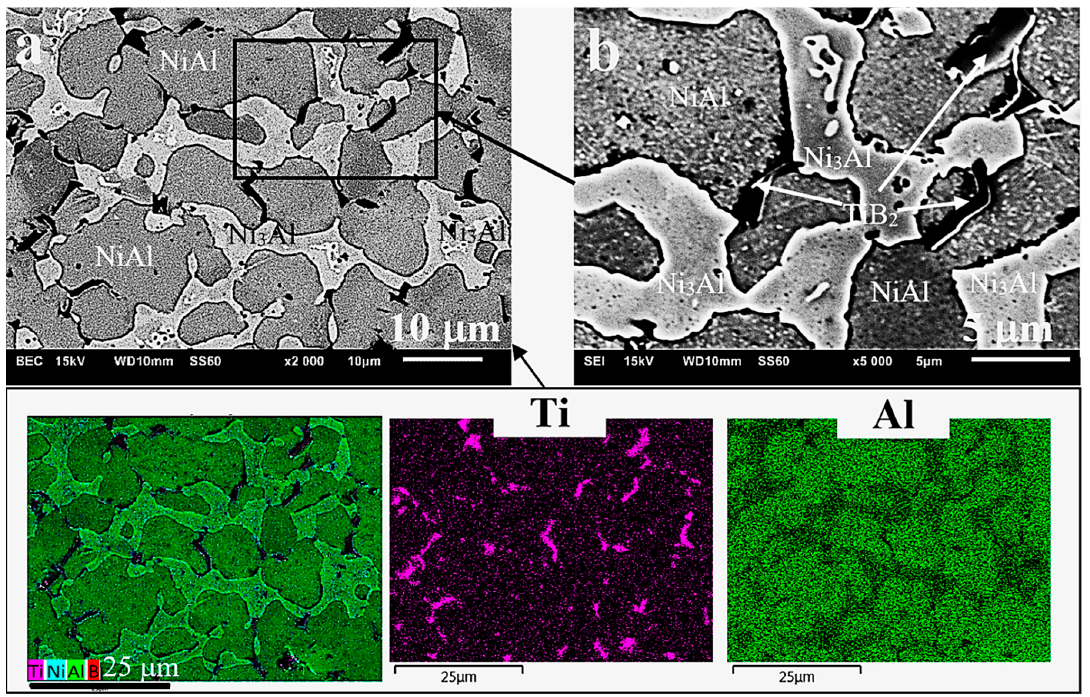
Figure 7. Microstructure of the NiAl / Ni 3 Al + TiB 2 composite; analysis of the ( a ) distribution (EDS map identification) and ( b ) shape of TiB 2 particles.